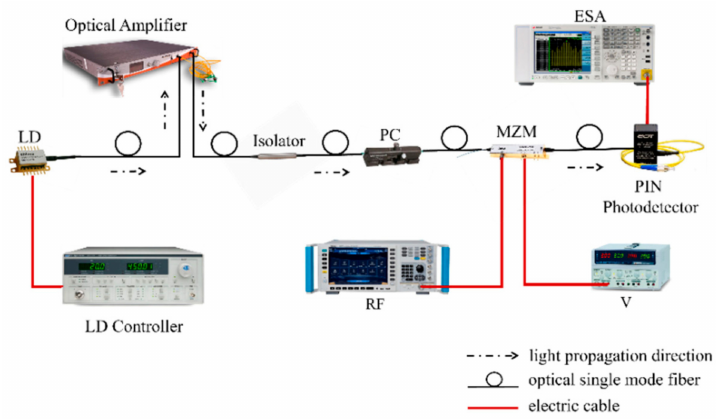
Figure 1. Experimental setup of the photonics-generated microwave carrier system at 2 µ m/1.55 µ m/1.31 µ m wavelengths using the DSB-CS modulation